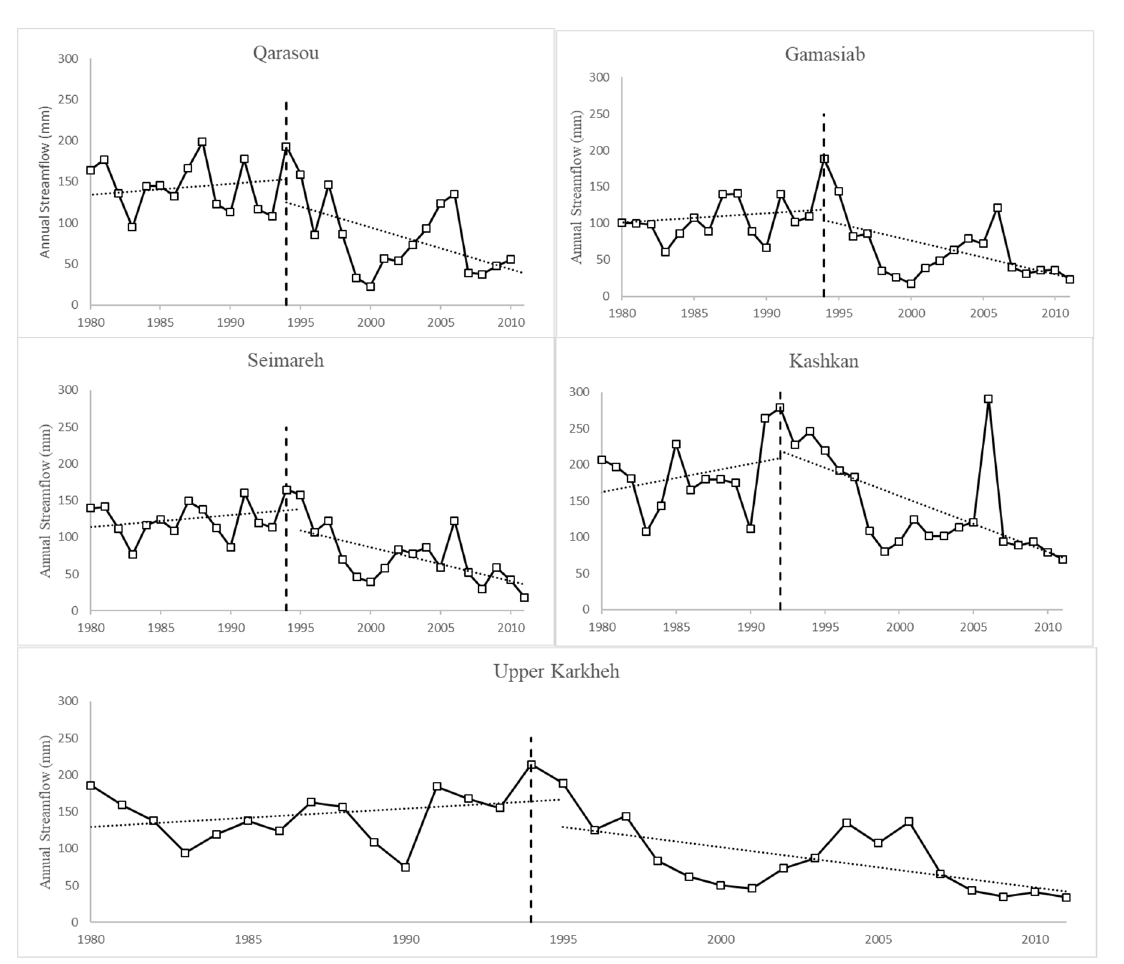
Figure 3. Streamflow trend in the sub-basins and their breakpoints as detected by DBEST. As presented in Table 3, all sub-basins experienced a reduction in precipitation and an increase in evapotranspiration from the pre- to post-change period. The Qarasou sub- basin showed the most severe decline in average annual precipitation ( − 19%), while the Kashkan sub-basin experienced a minimum change in precipitation (+1%) relative to other sub-basins. Table 3. E 0 and p variation during the pre- and post-change periods. Numbers 1 and 2 denote the pre- and post-change period, respectively. Sub-Basin